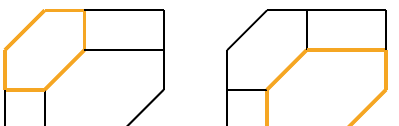
Figure 6 . Each cell is a Minkowski sum of sub-supports: the case (a), left and (b), right.